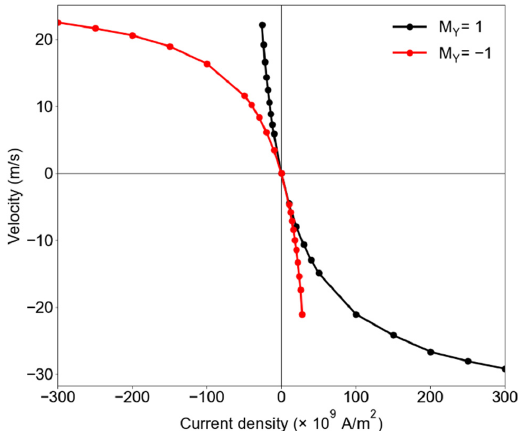
Figure 8. Velocity vs. current density for 𝐷 = 50 μJ/m 2 and opposing Bloch chiralities of the domain wall.